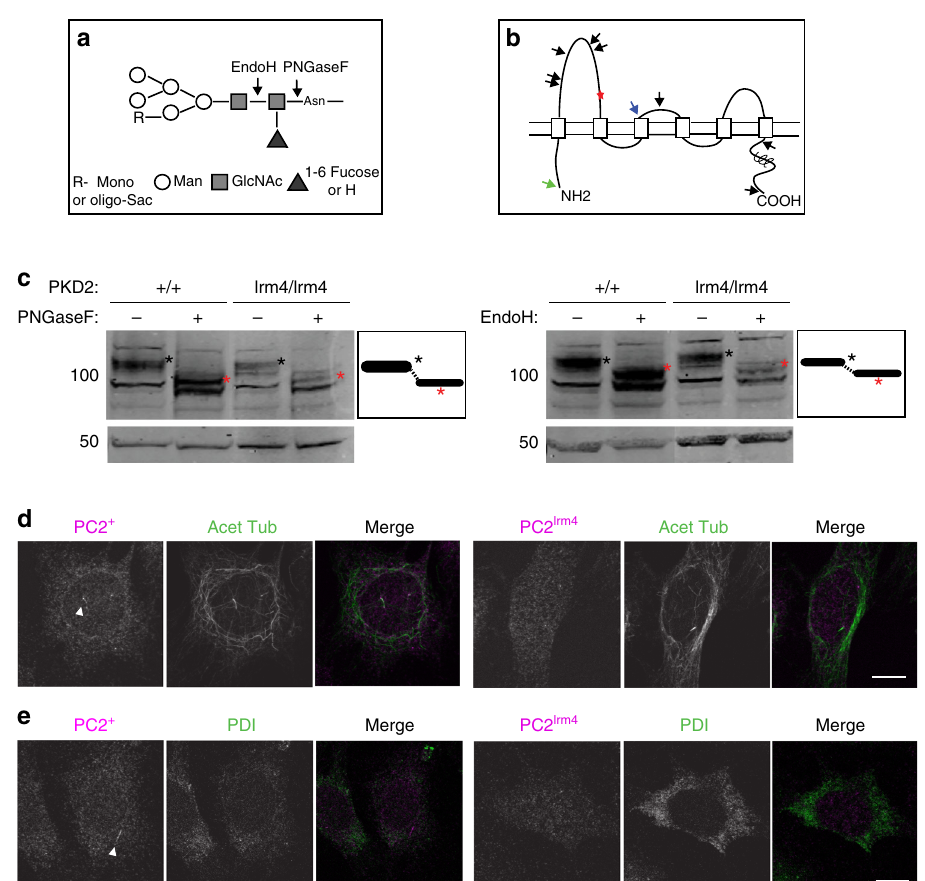
Fig. 3 N-glycosylation pattern and cellular location of PC2. a Diagram depicting cleavage sites of PNGaseF and EndoH. PNGaseF cleaves between the innermost GlcNAc and asparagine of a high mannose glycoprotein. EndoH cleaves between two core GlcNAcs of an N-linked, high mannose glycoprotein. b Schematic of predicted glycosylation sites in PC2 (compiled from graphs in Supplementary Fig. 7). The arrows represent predicted sites of glycosylation. The black arrows represent sites shared by mouse and human. Unique sites are present in both human (green arrow) and mouse (blue arrow) sequences. The Pkd2 lrm4 mutation site is marked with a red star in the fi rst extracellular loop. c MEF total cell lysates digested with PNGaseF or EndoH. To the right of each blot, a diagram represents the bands; a black asterisk (*) shows the undigested band and a red asterisk (*) indicates the enzyme-sensitive band. Both Wt (three left panels) and Pkd2 lrm4/lrm4 (right three panels) samples are PNGaseF and EndoH sensitive. Representative images of Pkd2 + / + and Pkd2 lrm4/lrm4 cells stained with PC2(red) and d acetylated tubulin (green) or e PDI marking the ER. Cells show no overall changes in cellular PC2 localisation. PC2 is seen at the base of the cilium in mutant cells. White arrow denotes PC2 in the cilium in Wt cells. Scale bar 10 μ